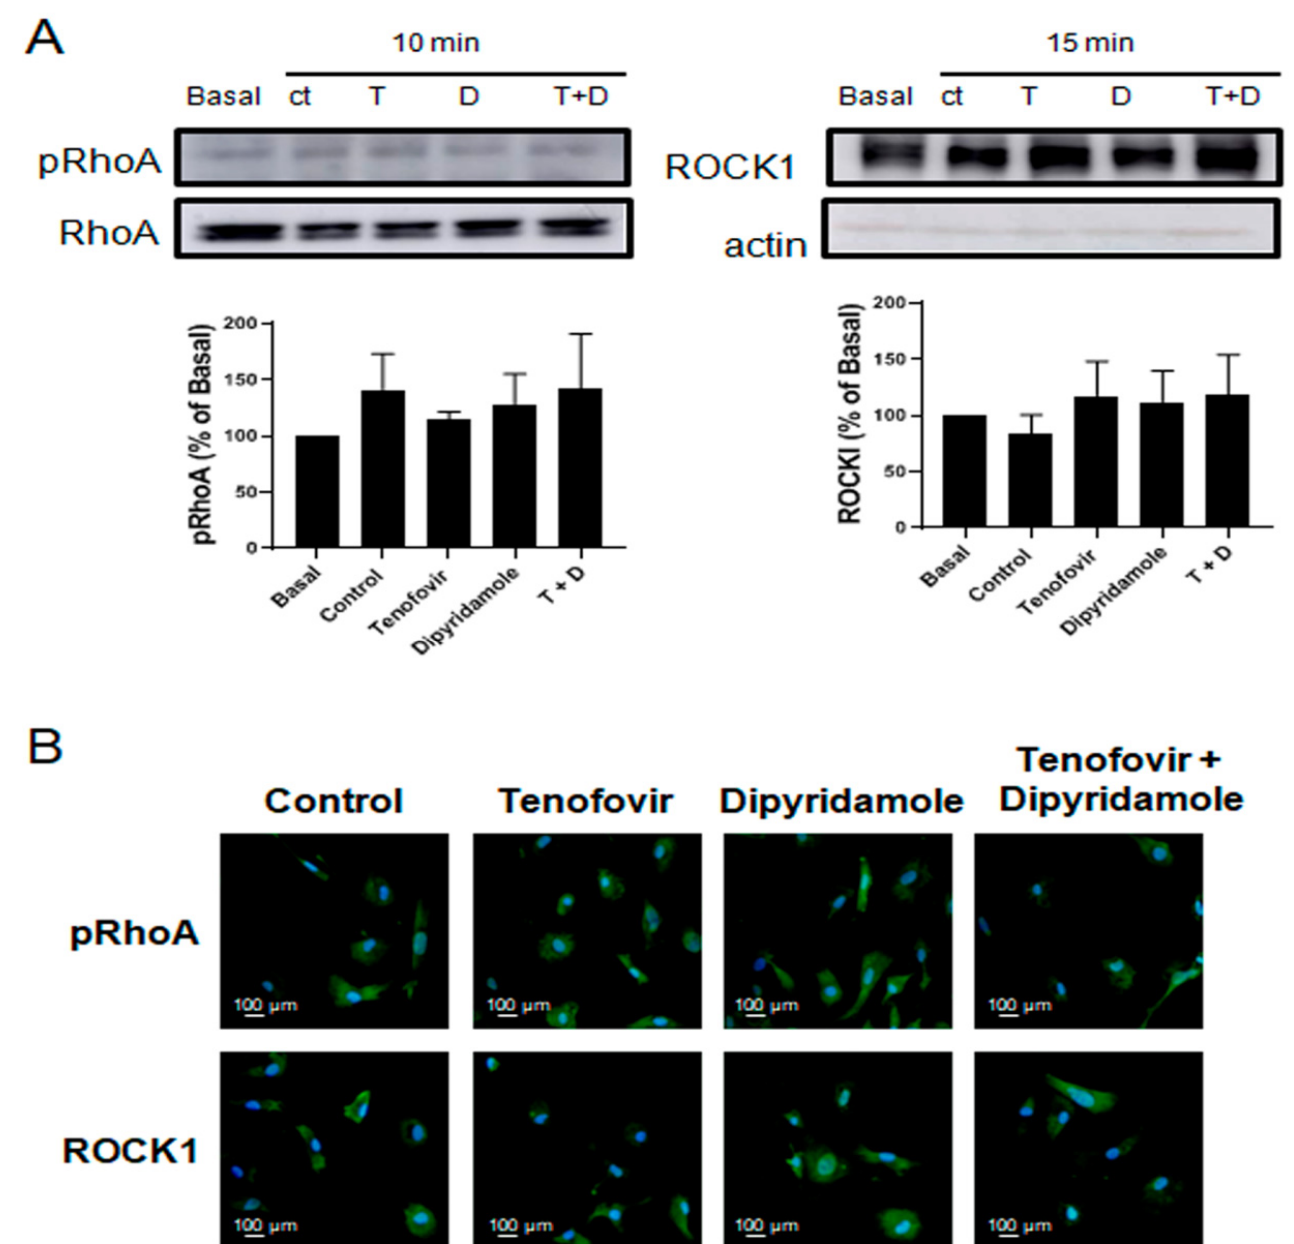
Figure 5. Phosphorylation of RhoA and ROCK1 activation were increased by tenofovir in osteoblast in A2AKO mice. ( A ) pRhoA and ROCK1 expression were studied in osteoblast precursors in the presence of tenofovir at 1 µ M alone or with dipyridamole at 1 µ M. To normalize for protein loading, the membranes were reprobed with RhoA or actin. ( B ) pRhoA and ROCK1 (green) immunostaining in osteoblast precursors treated with tenofovir at 1 µ M alone or with dipyridamole at 1 µ M. Nuclei are shown in blue (Dapi). All images were taken at 40 × magnification and scale bar indicates 100 µ m.